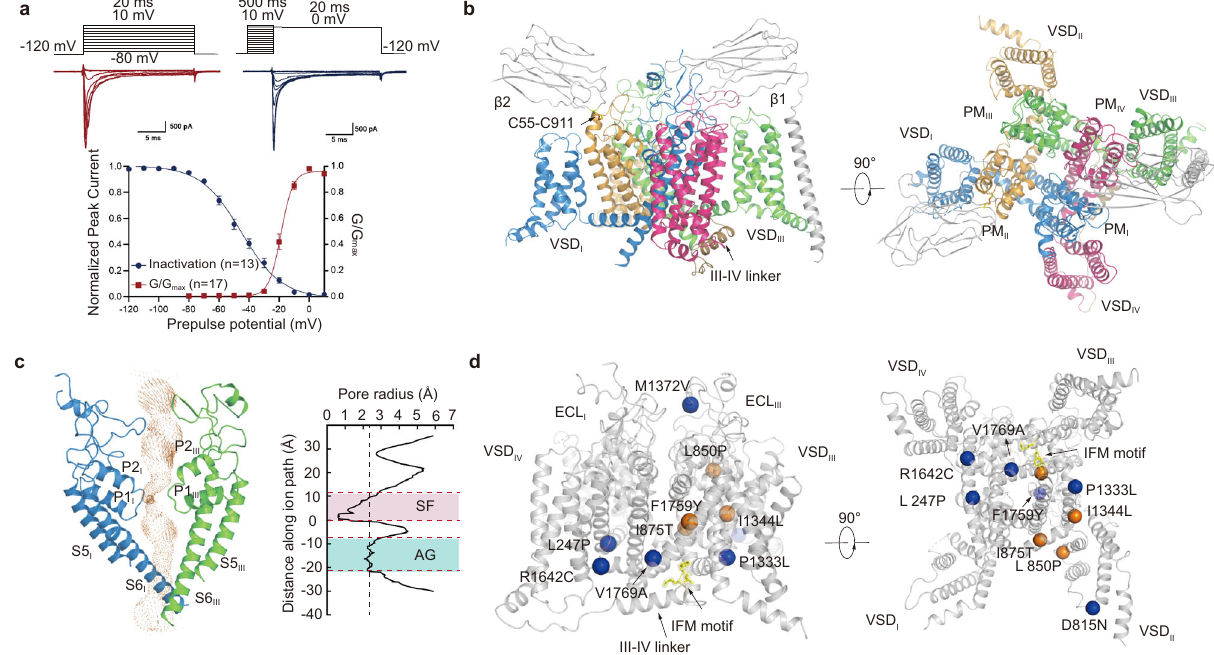
Fig. 1 Functional characterization and overall structure of human Na V 1.3/ β 1/ β 2. a Electrophysiological characterization of Na V 1.3. A family of sodium currents conducted by Na V 1.3 (Upper panel), a schematic diagram of the recording protocol is presented on top of each current traces respectively. Normalized conductance-voltage (G/V) relationship (Red squares) and steady-state fast inactivation (Blue circles) of Na V 1.3 (Lower panel). For measuring G/V curve, Na V 1.3/ β 1/ β 2 transfected HEK293T cells were measured with 20-ms depolarizing pulses between − 80 mV and 10 mV in steps of 10 mV from a holding potential of − 120 mV. For measuring steady-state fast inactivation, Na V 1.3/ β 1/ β 2 transfected HEK293T cells were applied pre-pulse potentials between − 120 mV and 10 mV in 10 mV increments for 500-ms followed by a 20-ms test pulse at 0 mV. The Boltzmann distribution has been fi tted to each data set, yielding voltage-dependent activation V 1/2 = − 18.8 ± 0.4 mV ( n = 17) and steady-state fast inactivation V 1/2 = − 45.4 ± 1.2 mV ( n = 13). b Overall structure of human Na V 1.3/ β 1/ β 2. The β 1 and β 2 subunits are colored in gray. The α subunit is colored in blue (D I ), orange (D II ), green (D III ), and magenta (D IV ). c Ion conductance path of Na V 1.3 calculated by HOLE. Plot of pore radii for Na V 1.3 is shown in the right panel, ligand in the cavity was omitted when calculating pore radius. Two constriction sites are highlighted for selectivity fi lter (SF) in pink and intracellular activation gate (AG) in light blue. d